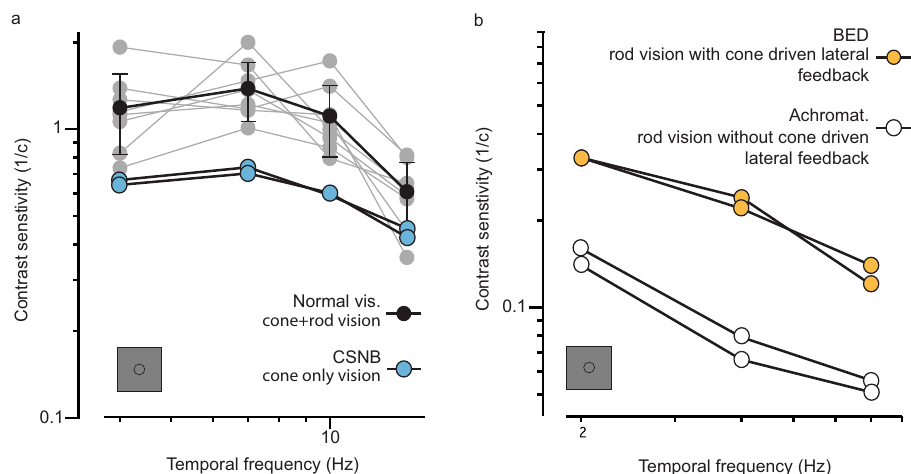
Fig. 3 Rod photoreceptors contribute to daylight vision and receive adaptive feedback from cones. Contrast sensitivity functions were measured using temporally modulated stimuli in the presence of an equiluminant surround. a Contrast sensitivity functions in normal vision subjects, where vision is cone + rod-mediated (black markers, data also shown in Fig. 1b, n = 8 subjects) and in two patients ( n = 2 patients) with congenital stationary night blindness (blue markers), with cone-only vision indicating that rod photoreceptors make a positive contribution to vision in daylight levels, almost doubling contrast sensitivity. b Contrast sensitivity functions for rod photoreceptors, obtained by silent substitution methods. In two tested BED patients ( n = 2 patients, orange markers), where L/M cones can drive lateral feedback to rods, contrast sensitivity was better than in two tested achromatopsia patients ( n = 2 patients; white markers), where rods receive no lateral feedback. All contrast sensitivity values are calculated as 1/contrast threshold (1/c). Error bars denote standard deviations around mean values. Source data are provided as a Source Data fi